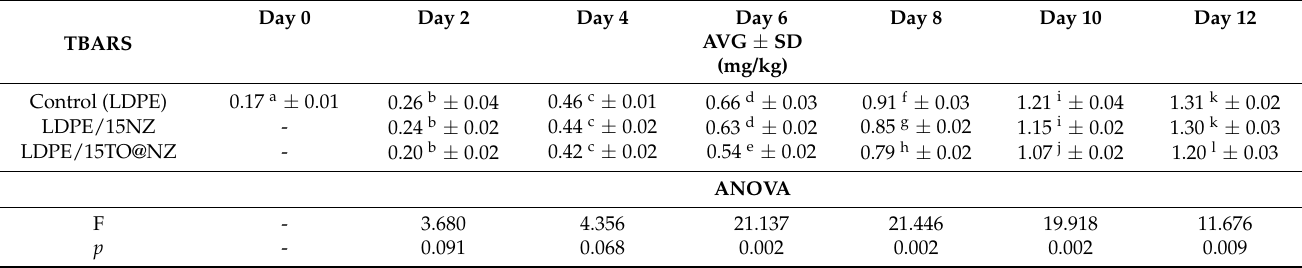
Table 4. TBARS and heme iron content of pork fillets in different packaging systems with respect to storage time. Differrent letters in its column indicate statistically significant differences at the p < 0.05 confidence level, as indicated by Post-hoc multiple comparison